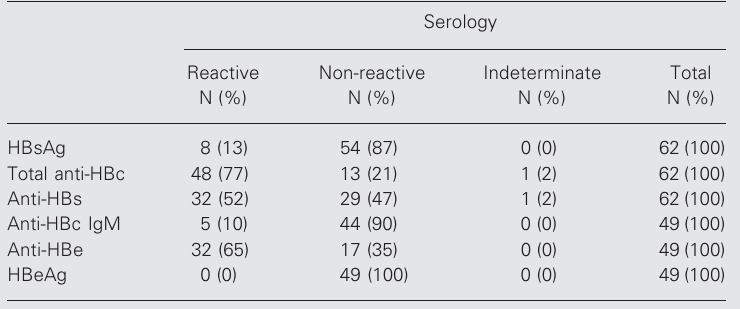
Table 1. Serologic data for the hepatitis B